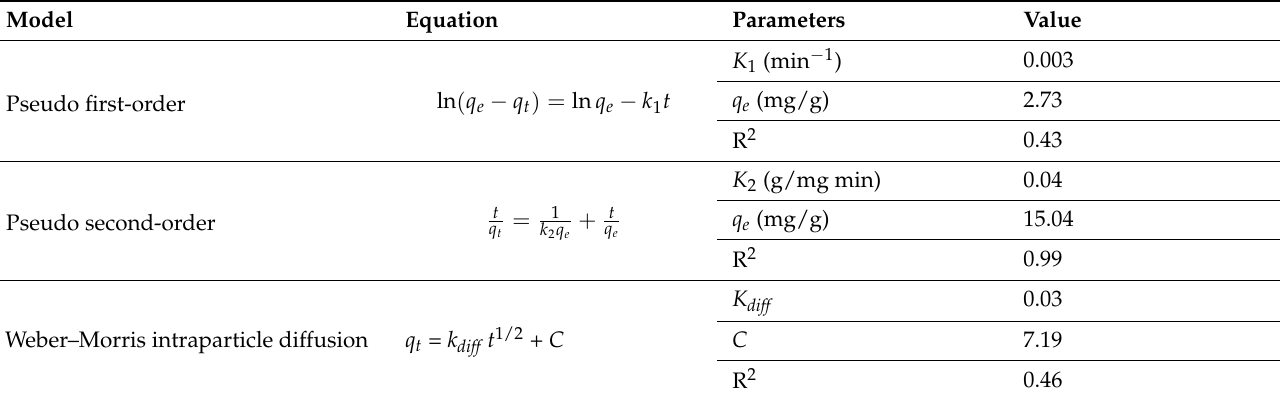
Table 3. Kinetic model used for PB dye uptake on